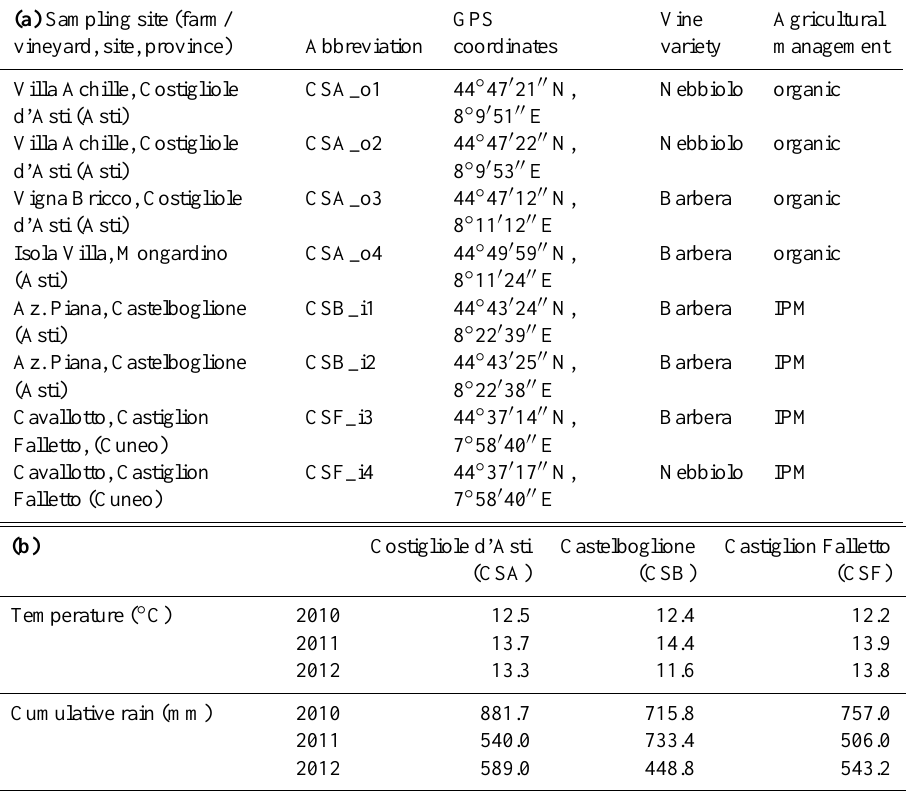
Table 1. (a) Description of vineyard sampling sites. (b) Yearly mean temperature and rain registered in the three vineyard sites.